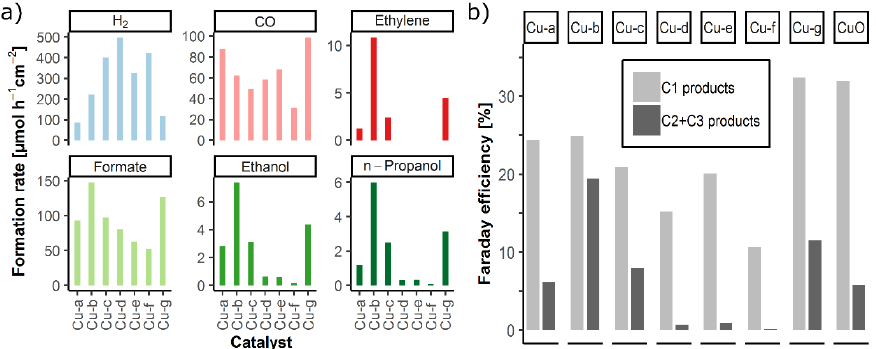
Figure 4. ( a ) Formation rates for hydrogen, carbon monoxide, ethylene, formate, ethanol, and n-propanol for all synthesized copper catalysts at E = − 1.7 V vs. Ag/AgCl in CO 2 saturated 0.5 M KHCO 3 . ( b ) Faraday efficiency of the C1 and C2 + C3 products: significantly increase in C2 and C3 for Cu-b compared to commercial CuO.